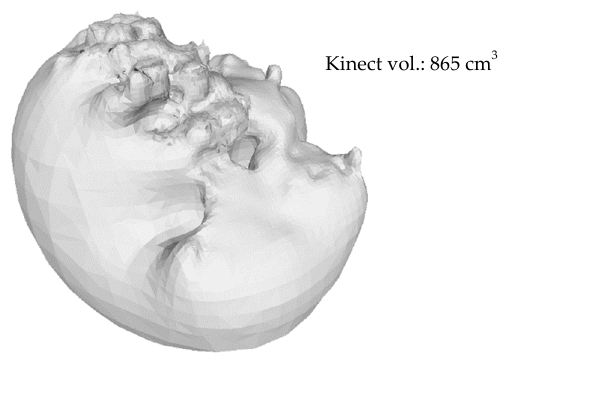
( f ) Figure 13. Presented RGB-D results of the three experiments; experiment one ( a ), experiment two FC (n = 21) ( b ), experiment two FC* (n = 20) ( c ), experiment two LR ( d ) and experiment three FC ( e ) & LR ( f ). {Key: Exp. = experiment; FC = full canopy; LR = leaf removal; *statistical outlier removed, resulting in 20 bunches}. The poor results obtained in experiment two’s FC dataset can be attributed to the mesh reconstruction step in the data-analysis process. Exaggerated reconstruction of bunches presents a